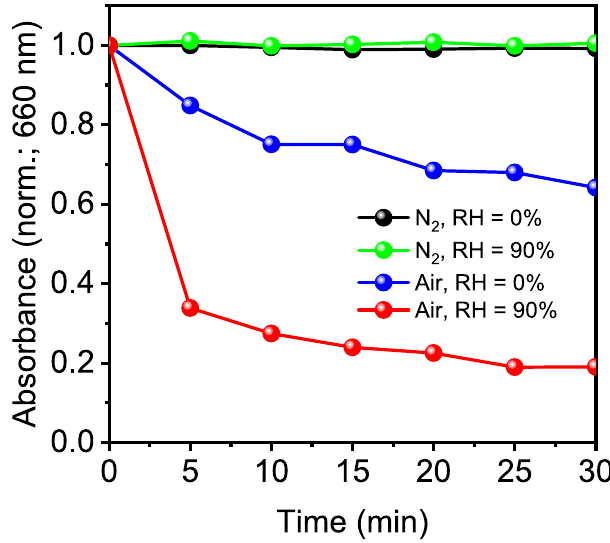
Fig. 5 Sn perovskite degradation tests under dry/moist air/nitrogen fl ow. Optical degradation of (PEA) 0.2 (FA) 0.8 SnI 3 fi lms at 660 nm upon exposure to a fl ow of dry N 2 (RH = 0%), moist N 2 (RH = 90%), dry air (RH = 0%) and moist air (RH = 90%).